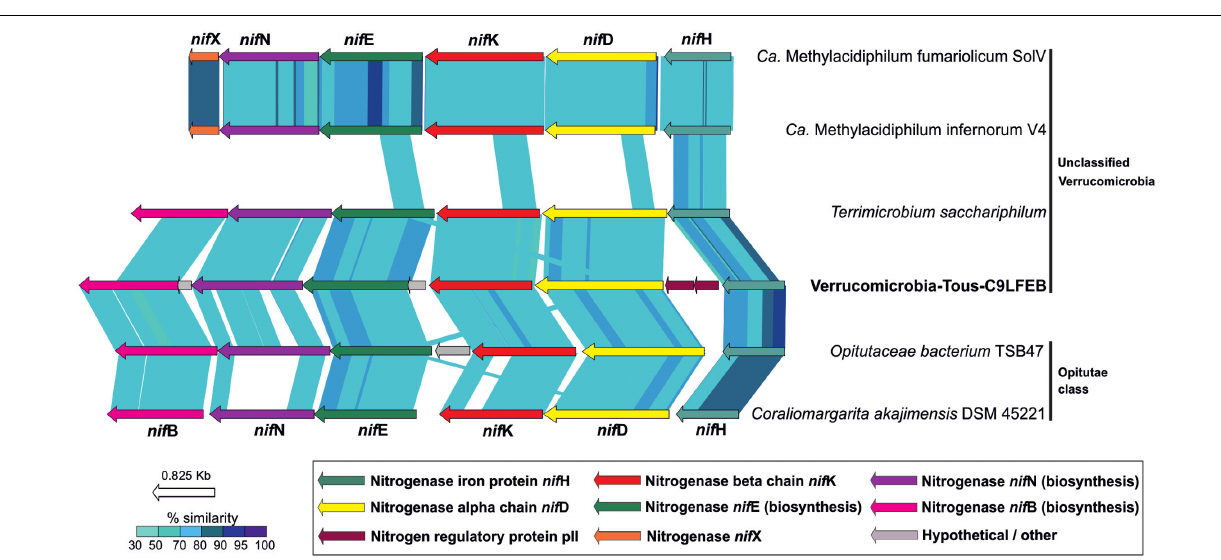
FIGURE 6 | Structure and synteny of the nitrogenase operon among different Verrucomicrobia . A minimum set of six proteins are represented in the operon. NifH, NifD, and NifK comprise the catalytic domain of the nitrogenase. NifN, NifE, and NifB comprise the biosynthetic domain. Comparison made with TBLASTX with > 50% similarity hits and 50 bp alignment